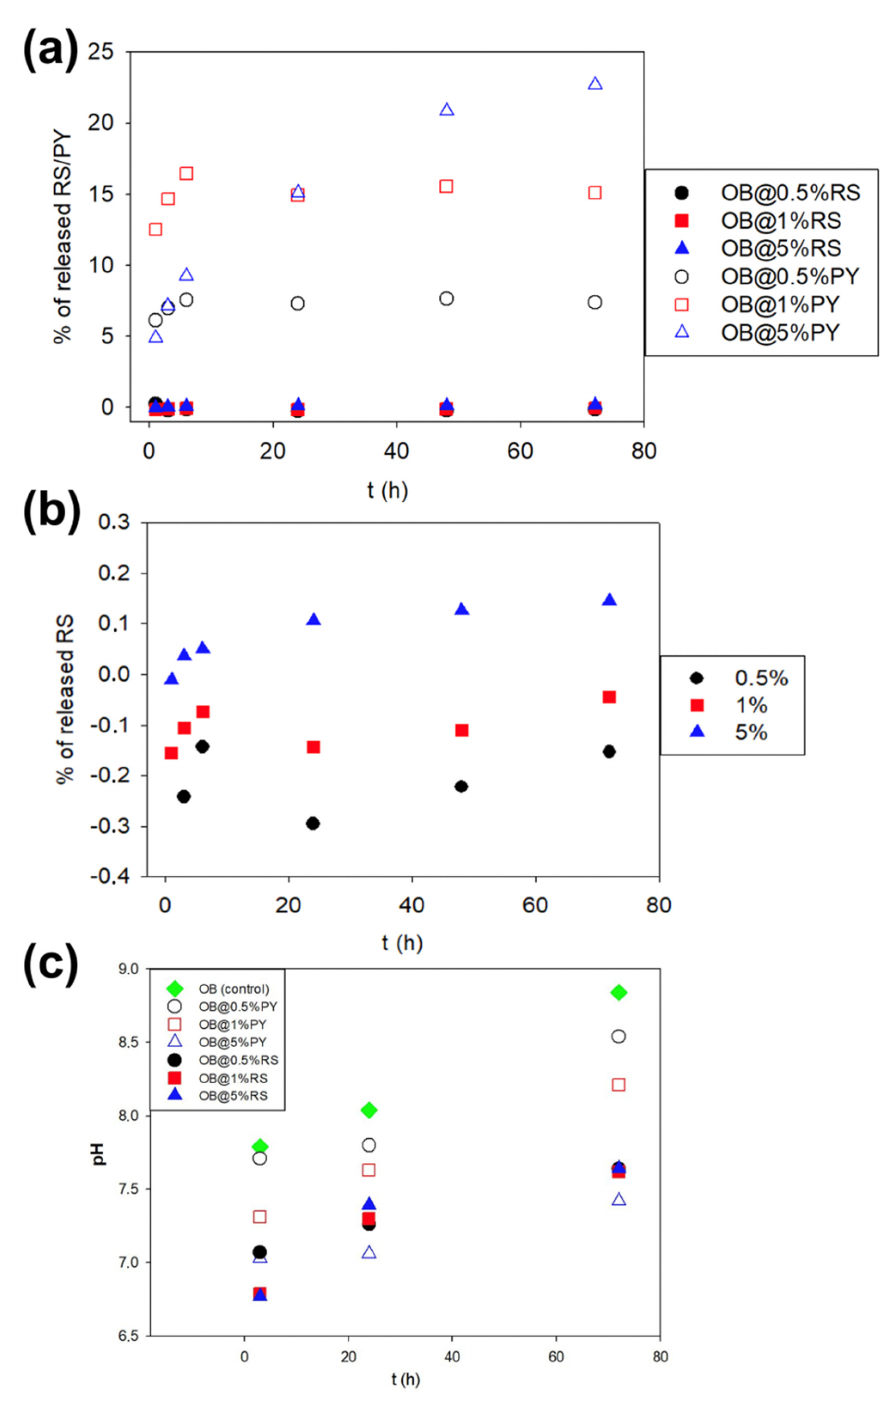
1 Figure 4. ( a ) Percentages of RS and PY released from the different composites versus time with respect to different initial mass fractions in the composites; ( b ) percentages of RS released from the different composites versus time with respect to the different initial mass fractions in the composites; ( c ) pH changes with time of water put in contact with sealer sample (control) and sealer modified with different concentrations of PY and/or RS as shown in the